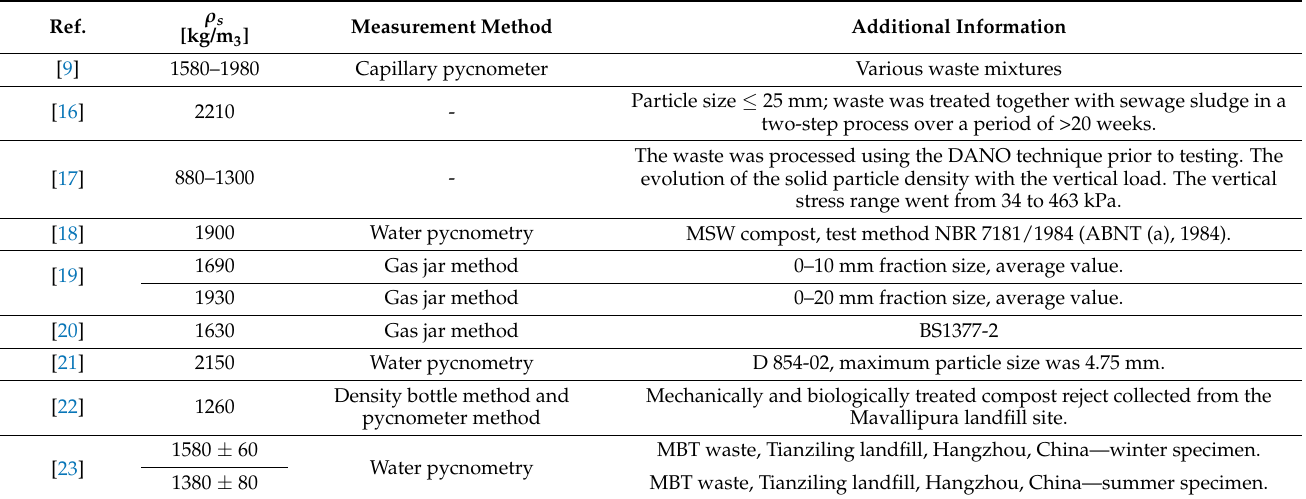
Table 1. Solid particle densities of the MBT waste collected from the published literature.